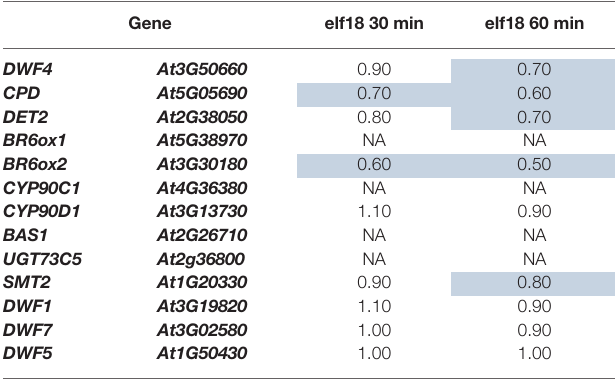
TABLE 2 | Expression changes in BR biosynthetic genes in response to treatment with elf18.